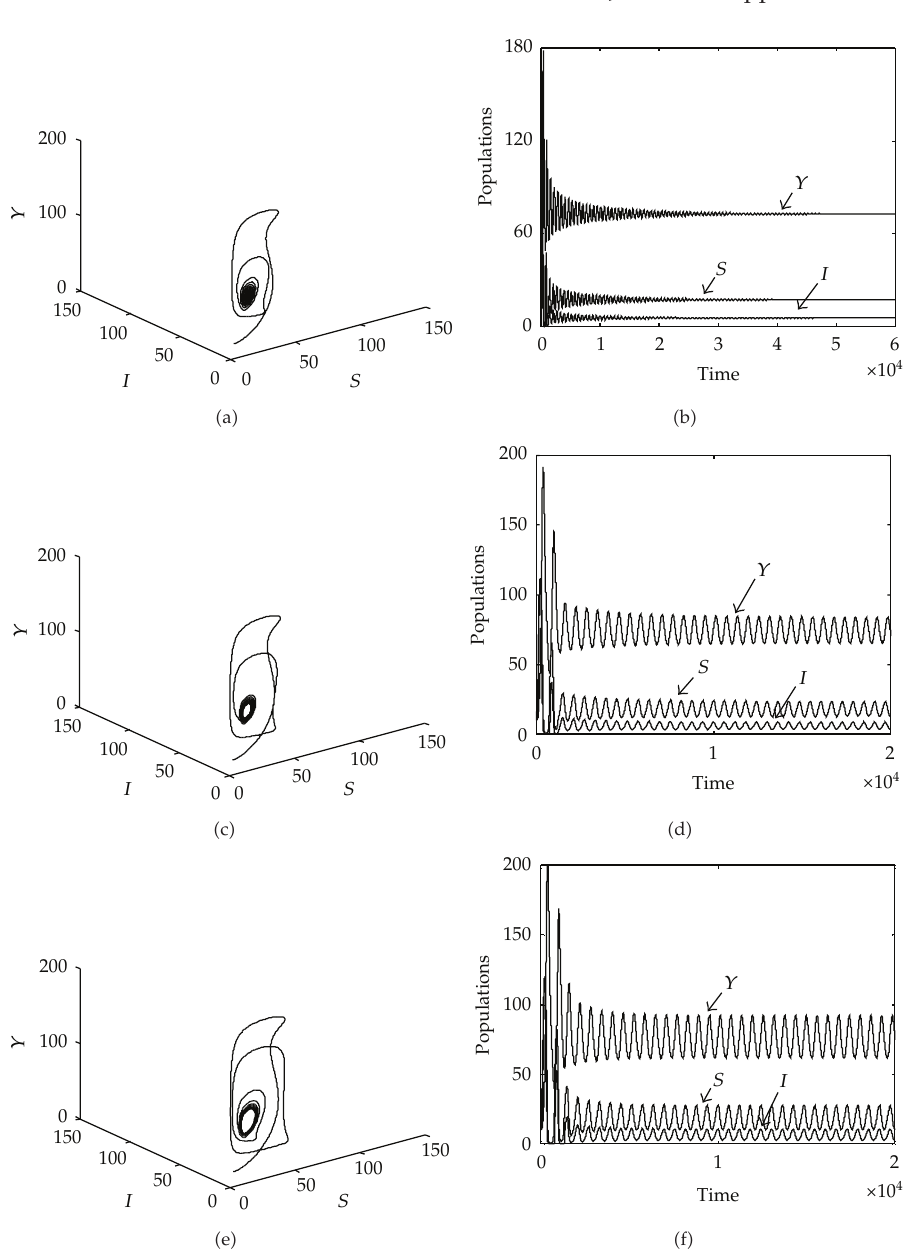
∼ (cid:8) 270 keeping